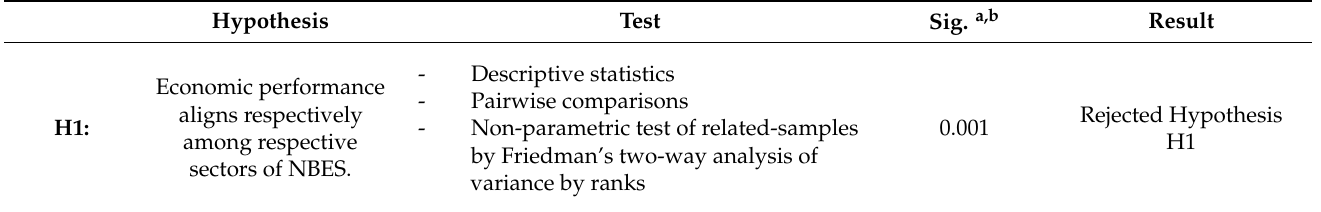
Table 2. Portrays results summary of Hypothesis